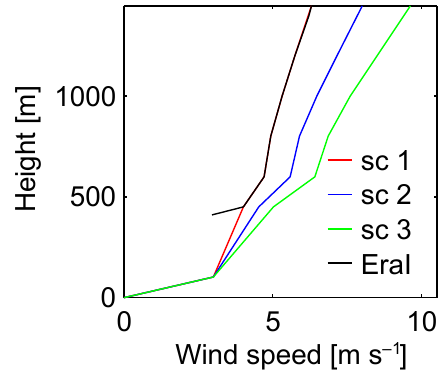
Figure 3. Geostrophic wind profile scenarios used for the model simulations. The black line shows the mean EraI wind profile over the Bergen Valley for all high-pollution cases (they start only at 410m due to the low horizontal resolution of EraI). Above 450m the red and black lines are overlapping. Figure 4. The 55m wind field from case 3 together with H s (Kms − 1 ) . The figure shows the mean fields over the last 15min of the 12h simulation time. Wind vectors point into the flow direc- tion. The wind vector in the upper right corner indicates the scale of the wind vector length. It shows a wind speed of 3ms − 1 . The 55m topographic line is indicated by the thick black dashed line. The water–land interface is shown by the thick solid